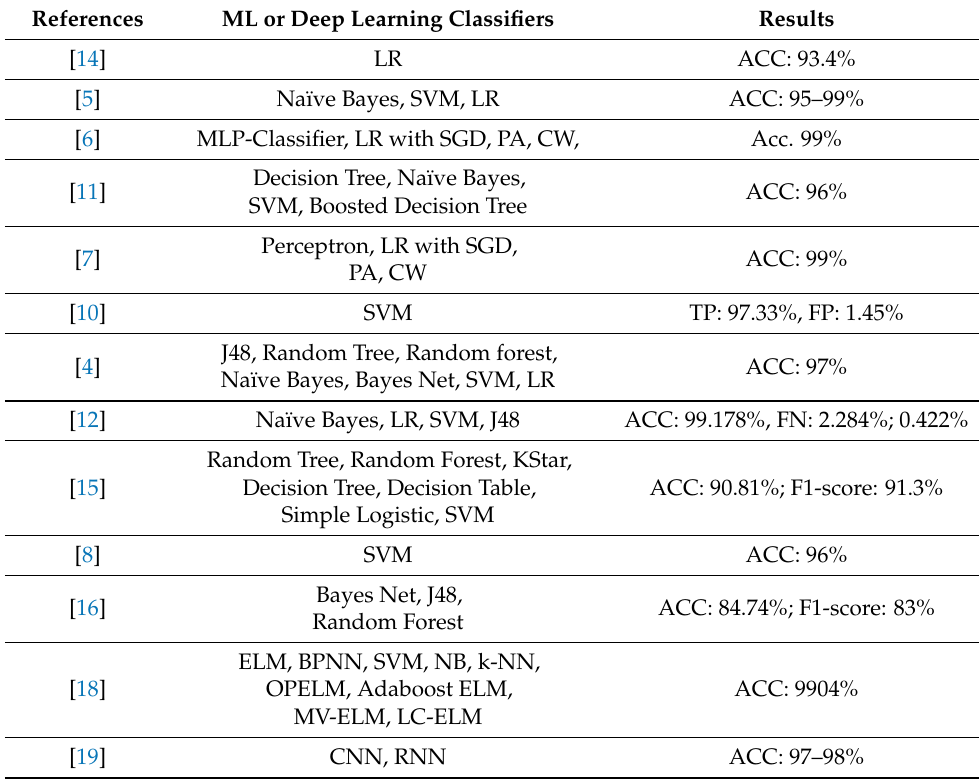
Table 1. List of research papers in which different ML algorithms were used for the detection of malicious websites with achieved